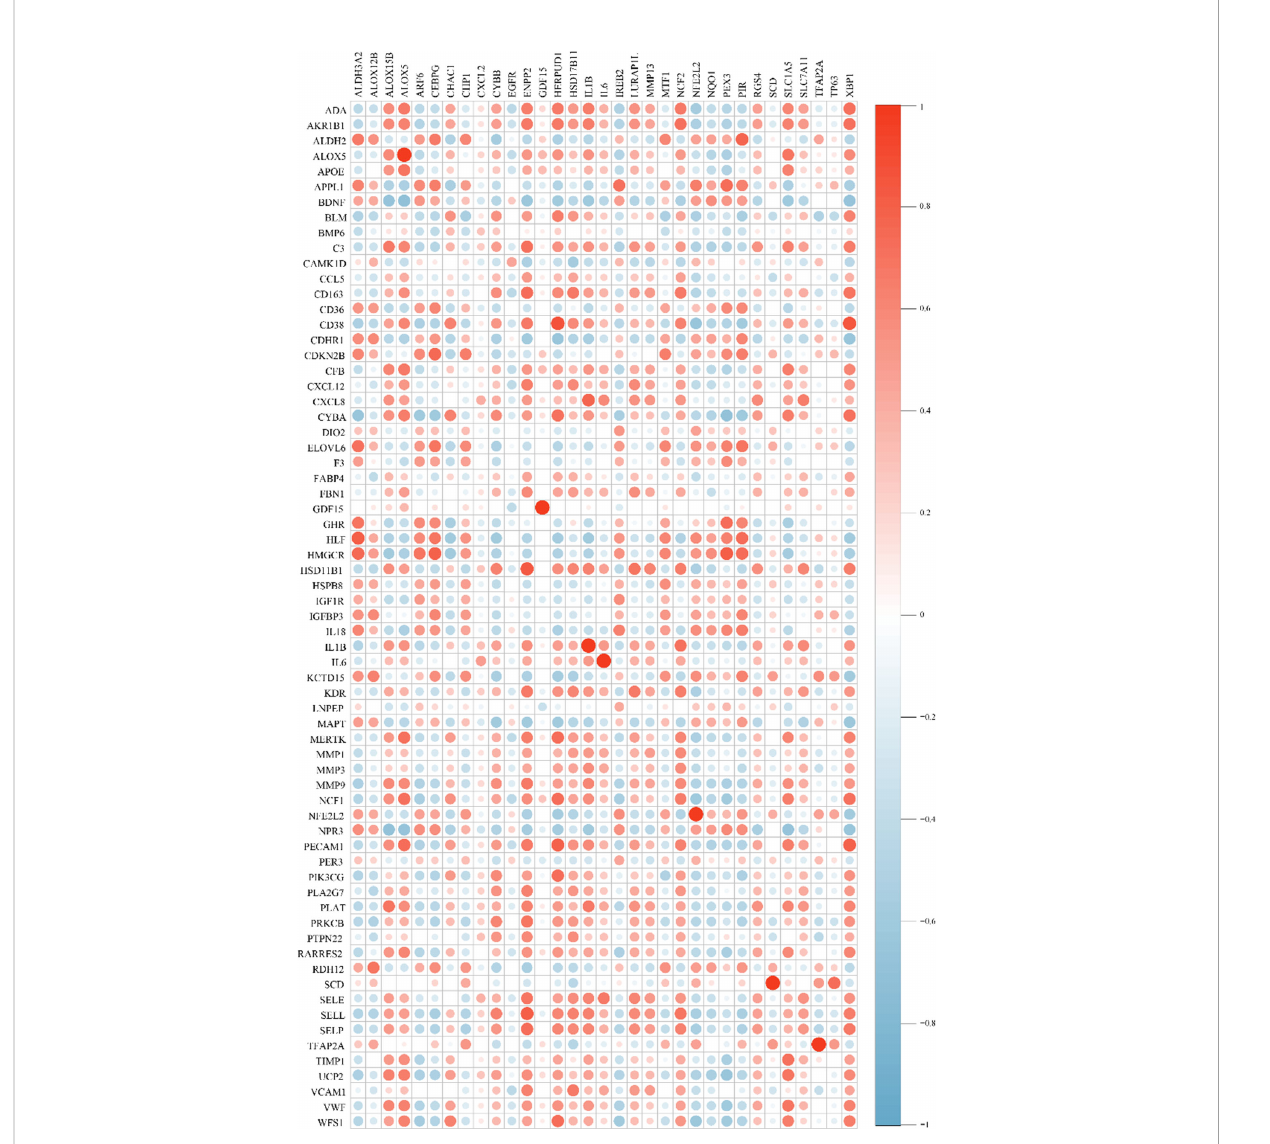
FIGURE 4 Correlation analysis between cross-talk genes and ferroptosis-related genes. Genes in the vertical line are cross-talk genes and genes in in the horizontal line are FRGs. Red indicates a positive correlation, blue indicates a negative correlation. The size of circle designates the correlation coef fi cient between cross-talk genes and ferroptosis-related